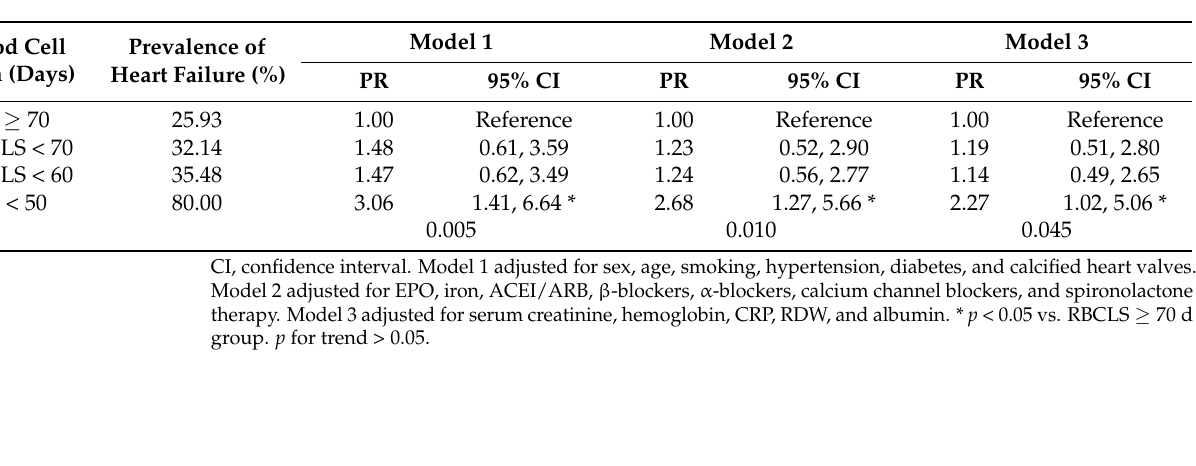
Figure 2. Relationship between RBCLS and cardiac color Doppler ultrasound indicators. Each data point is an individual measurement. The pink line represents the linear regression fitting line. ( a ) LAD (beta = −10.98, p = 0.02); ( b ) LVDs (beta = −16.30, p = 0.002); ( c ) LVDd (beta = −10.82, p = 0.013); ( d ) IVST (beta = −21.12, p = 0.061); ( e ) LVPWT (beta = −36.03, p = 0.007); ( f ) LVM (beta = −0.12, p = 0.001); ( g ) LVEF (beta = 0.87, p = 0.025); ( h ) E/e (beta = −1.28, p = 0.012). Table 3. Association analysis of different RBCLS with heart failure at baseline.